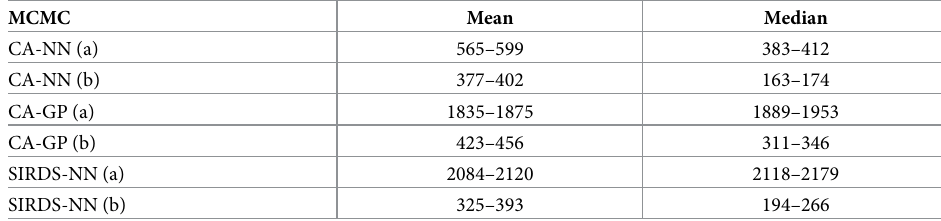
Table 2. Median and mean autocorrelation length for different MCMC setups. For each of the two ABMs (our can- cer CA and epidemiological SIRDS model), we use two ML emulation algorithms (NN and GP). We distinguish between two different likelihoods (case a and b, cf. the methods section). The first column specifies the different setups by first naming the ABM, followed by the emulator and the likelihood.